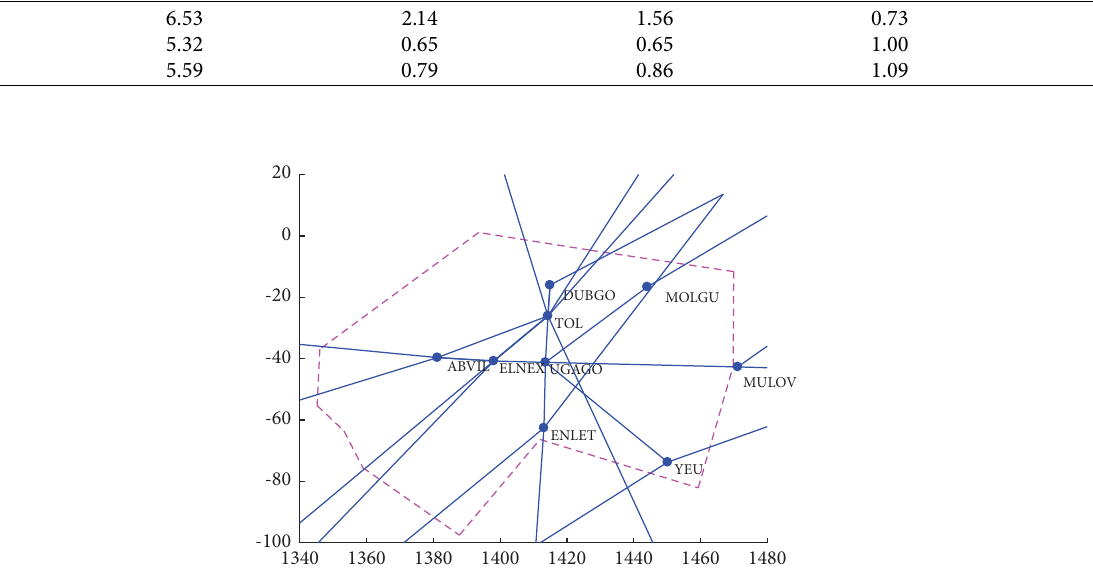
Figure 7: Schematic diagram of airspace structure in Shanghai sector 01.